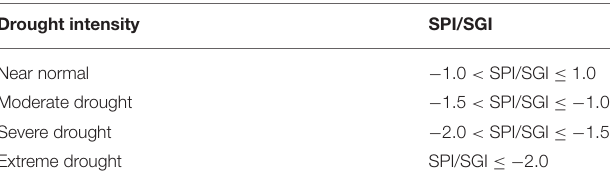
TABLE 3 | Drought intensity according to SPI/SGI (McKee et al., 1993; Bloomfield and Marchant,